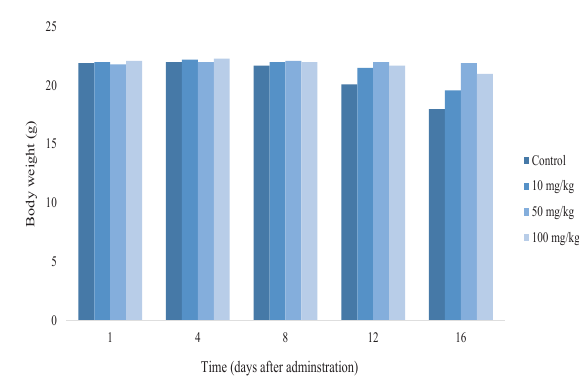
Figure 1. PAHE effects on body weight (g) in the animal model of ER+ breast cancer.